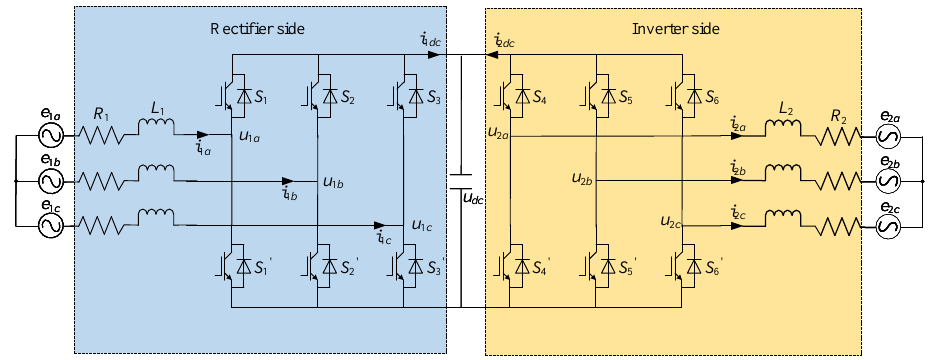
Figure 1. Structure of the two-port SOP with the rectifier side and the inverter